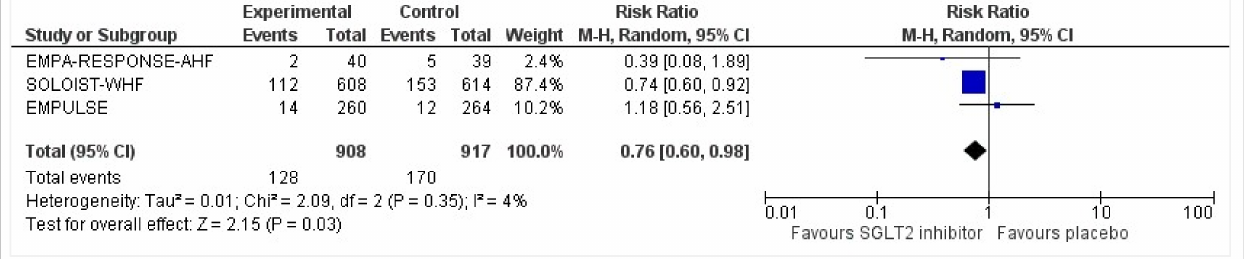
Figure 5. Forest plot for the number of patients requiring readmission following discharge for acute heart failure in either group